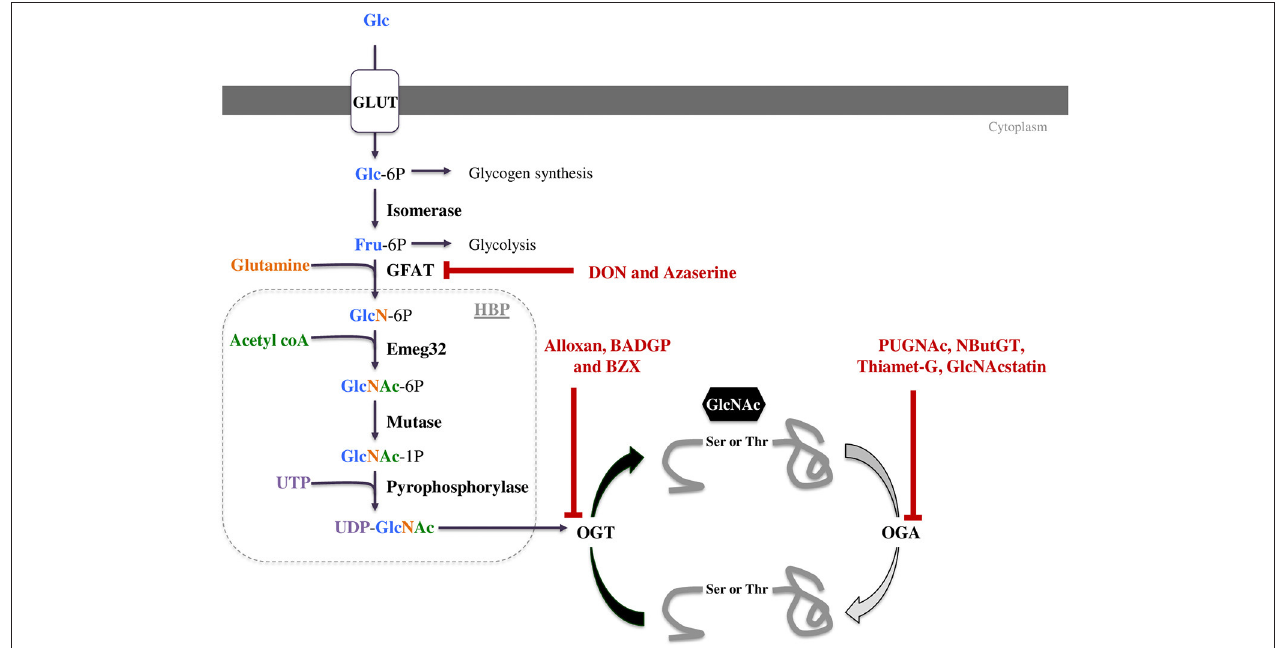
FIGURE 1 | The hexosamine biosynthetic pathway (HBP) leads to UDP-GlcNAc formation and regulates O- GlcNAcylation. This pathway is regulated by only three enzymes: GFAT (glutamine fructose-6P aminotransferase), OGT ( O- GlcNAc transferase) and OGA ( O- GlcNAcase). These three enzymes can be targeted by pharmacological compounds to modulate O -GlcNAc levels. Some of them decrease O- GlcNAc levels such as DON and azaserine inhibiting GFAT or Alloxan, BZX and BADGP inhibiting OGT. OGA inhibitors like PUGNAc, NButGT, Thiamet-G and GlcNAcstatin increase protein O